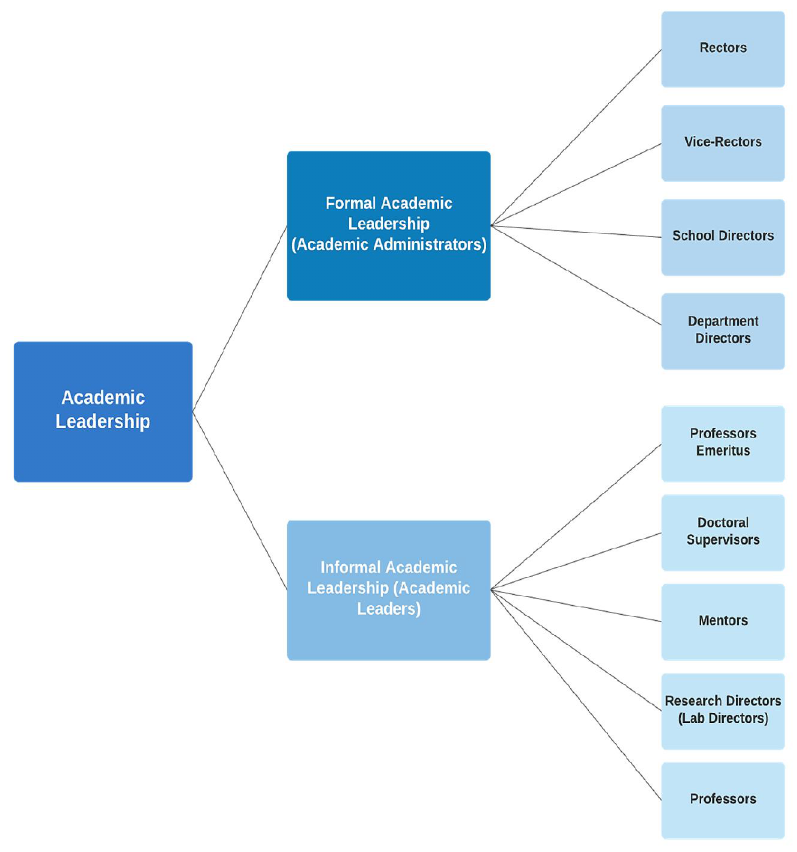
Figure 1. Academic Formal / Informal Leadership